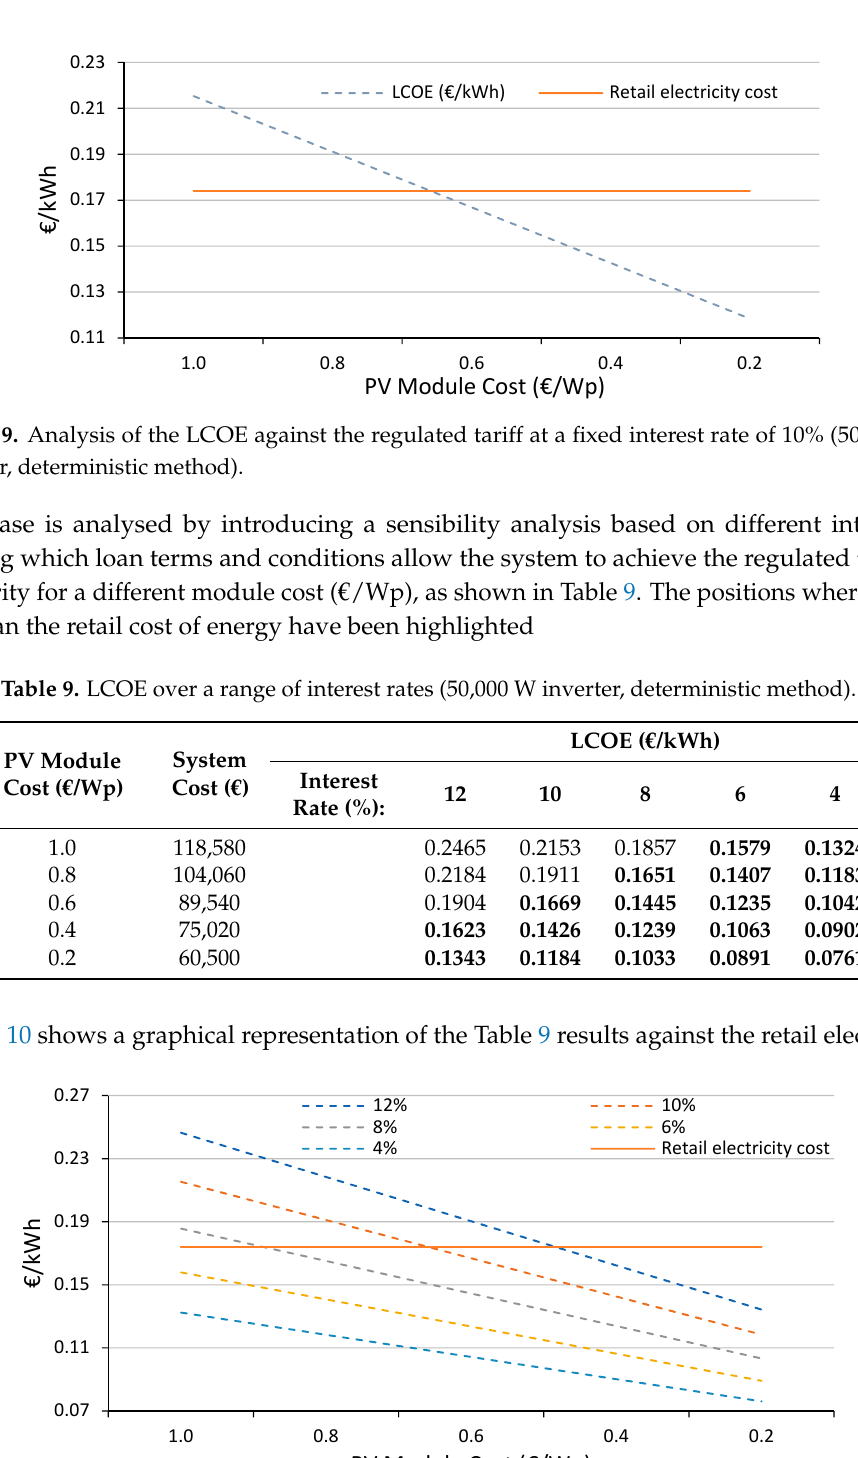
Figure 10. Analysis of the LCOE against the retail electricity cost at various interest rates (50,000 W inverter, deterministic method).